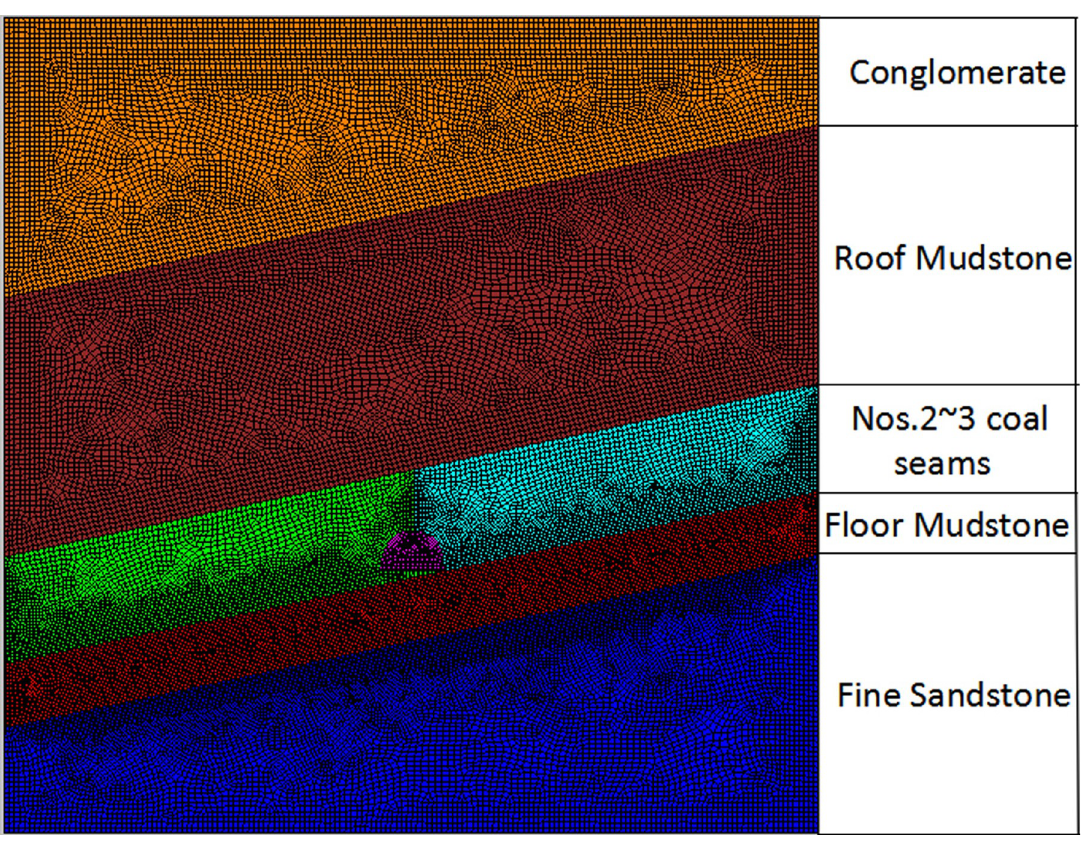
Fig 12. Numerical simulation